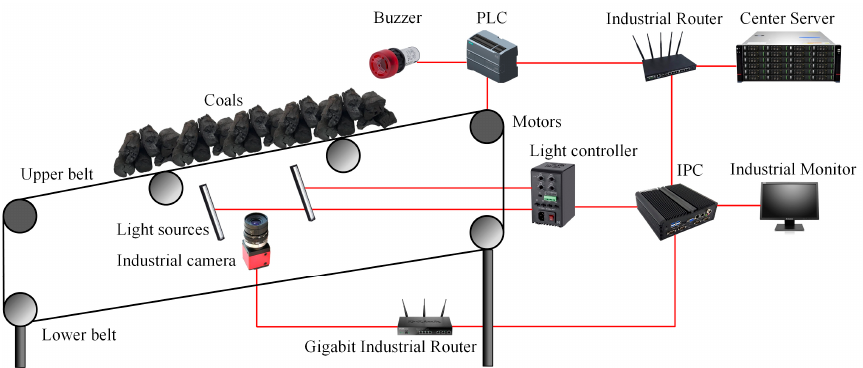
Figure 4. The hardware framework of the conveyor belt damage detection system.